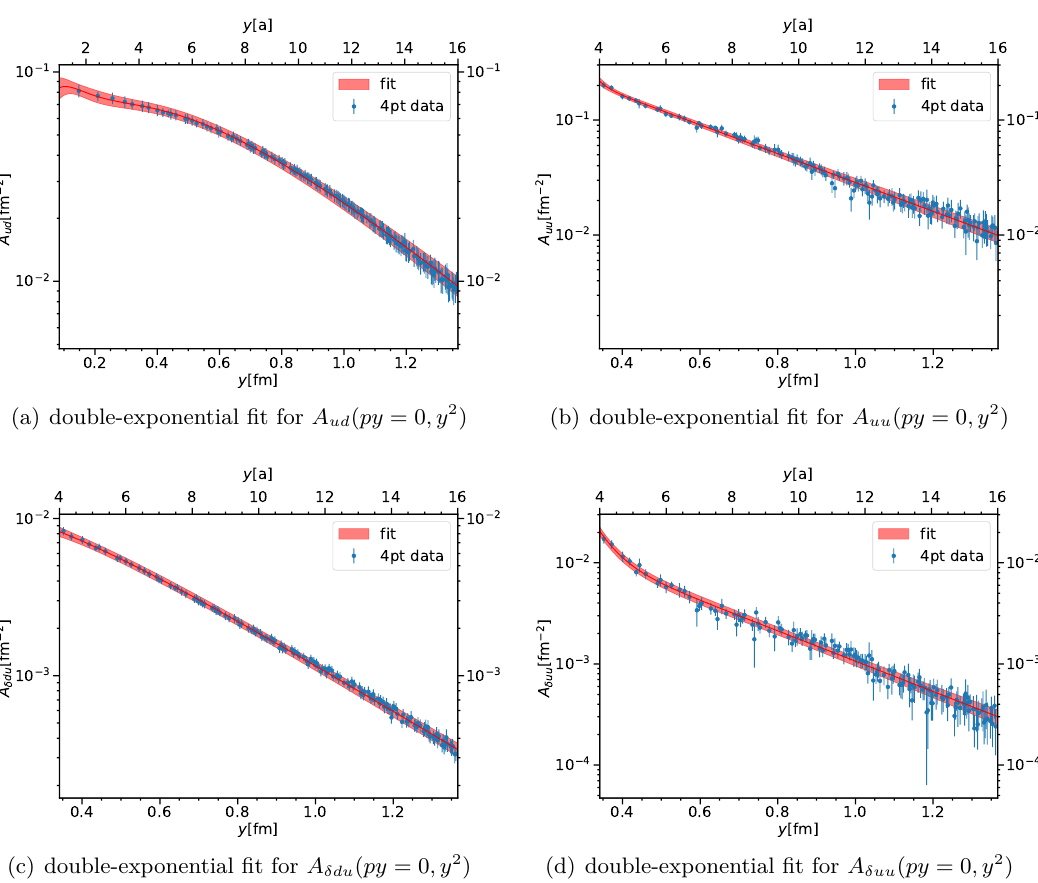
(d) double-exponential fit for A δuu ( py = 0 , y 2 ) Figure 14 . Data points for the twist-two functions compared to the corresponding curve resulting from a fit to the form (4.2). Each plot has a logarithmic scale for the vertical